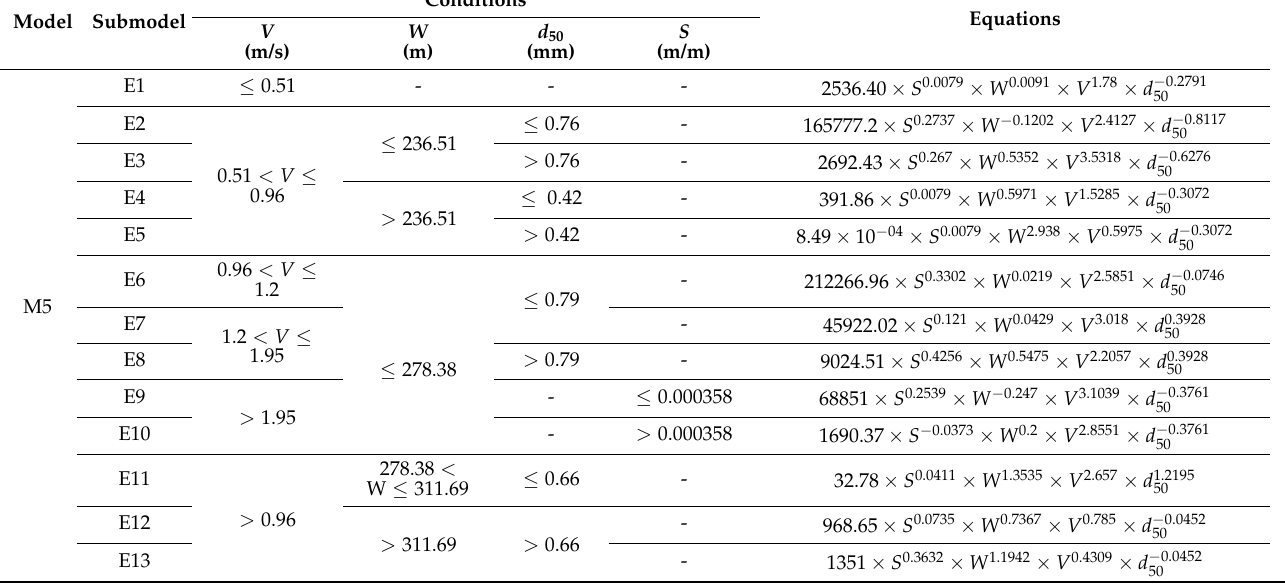
Table 5. Application conditions and determination coefficients of Model 5 (M5).